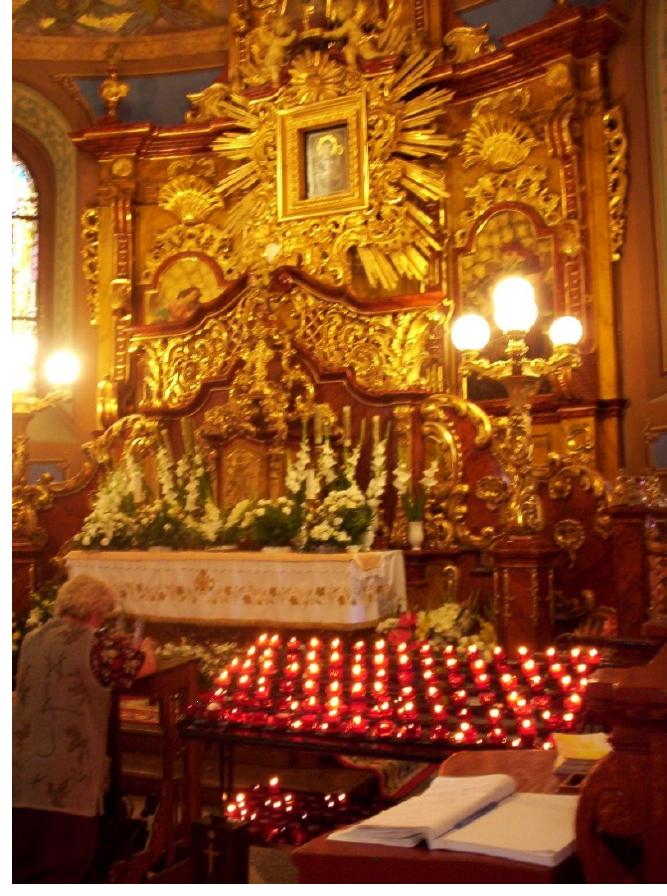
Figure 5. The Goestbook in Máriapócs, Photo taken by Krisztina Frauhammer,